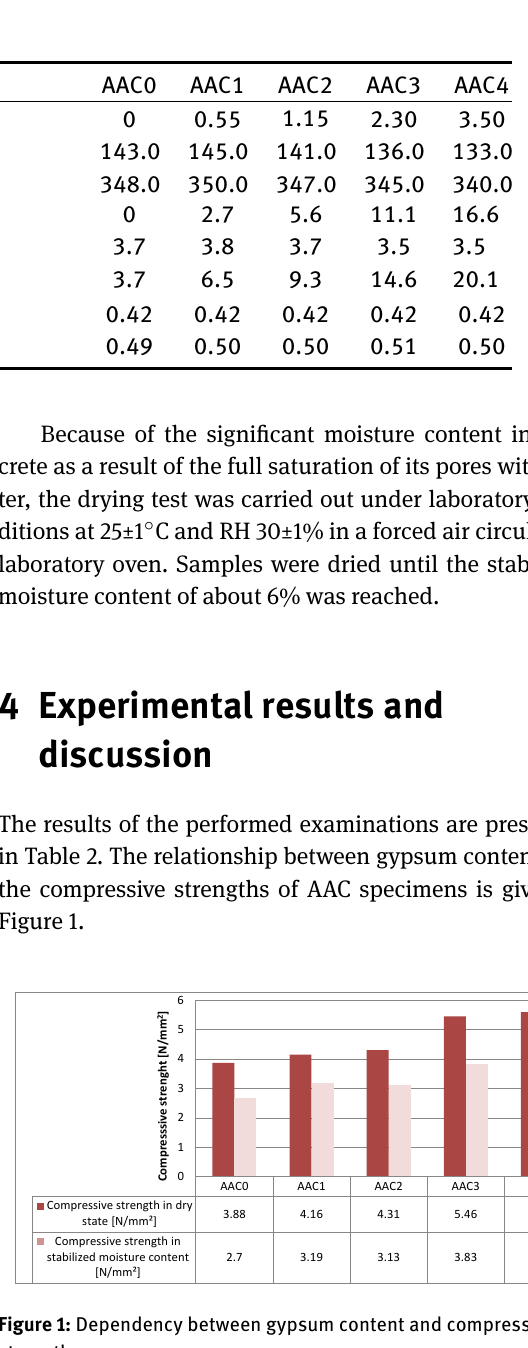
The compressive strength tested on both dried and stabilized moisture specimens as well as tensile strengths increases with the increase of gypsum content. This in- crease is significant when gypsum content exceeds 2% of dry weight. There was no significant effect of sulphate addition on the maximum water absorption of AAC samples